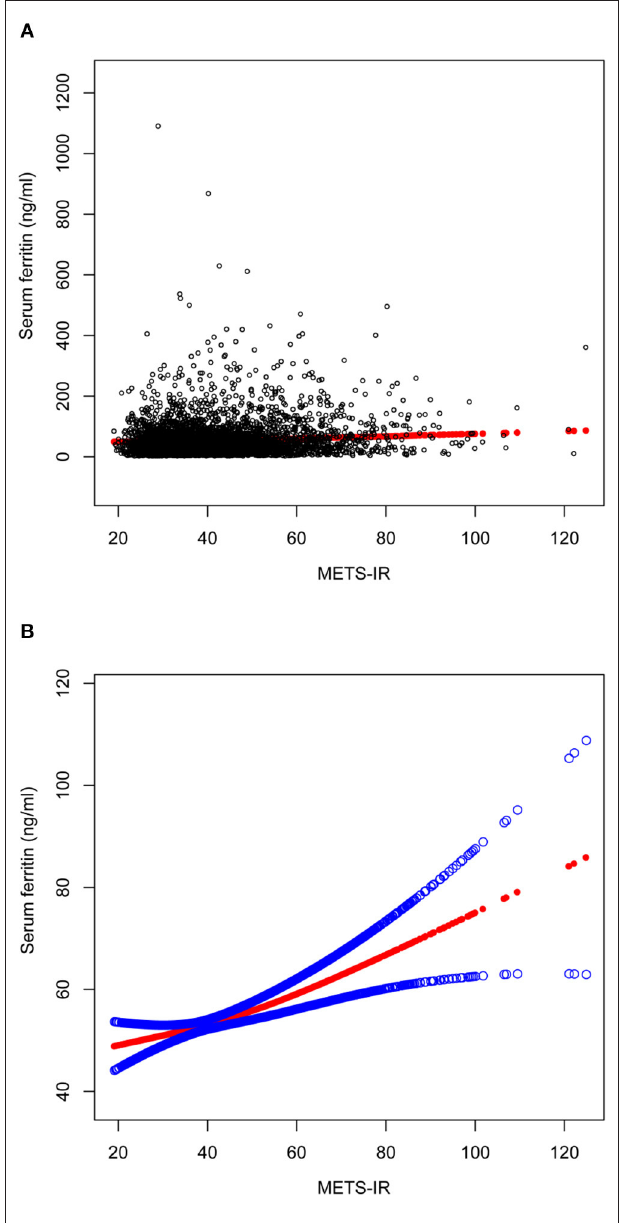
FIGURE 2 | The association between METS-IR and serum ferritin. (A) Each black point represents a sample. (B) Solid red line represents the smooth curve fit between variables. Blue bands represent the 95% of confidence interval from the fit. All the covariates in Table 1 were adjusted.